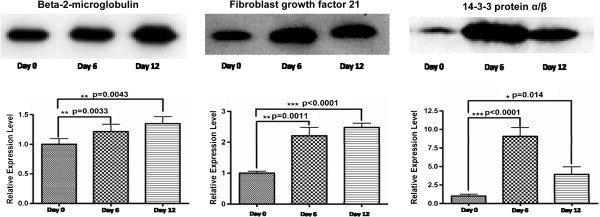
Validation of differentially expressed perfusate proteins in plasma. Beta-2-microglobulin (B2-M), Fibroblast growth factor 21 (FGF 21) and 14-3-3 protein α/β (Ywhab) were chosen for validation by Western blotting. The plasma was collected at three time-points from each model rat: on days 0, 6 and 12 (before the surgical inoculation and on the sixth and twelfth day after inoculation, respectively). Equal volumes of plasma were loaded into a gel and analyzed by Western blotting. The change direction in the relative abundance of 14-3-3 protein α/β in the perfusates was the same as in the plasma, whereas the change direction in the relative abundance of the B2-M and FGF 21 proteins was opposite to that in the plasma.